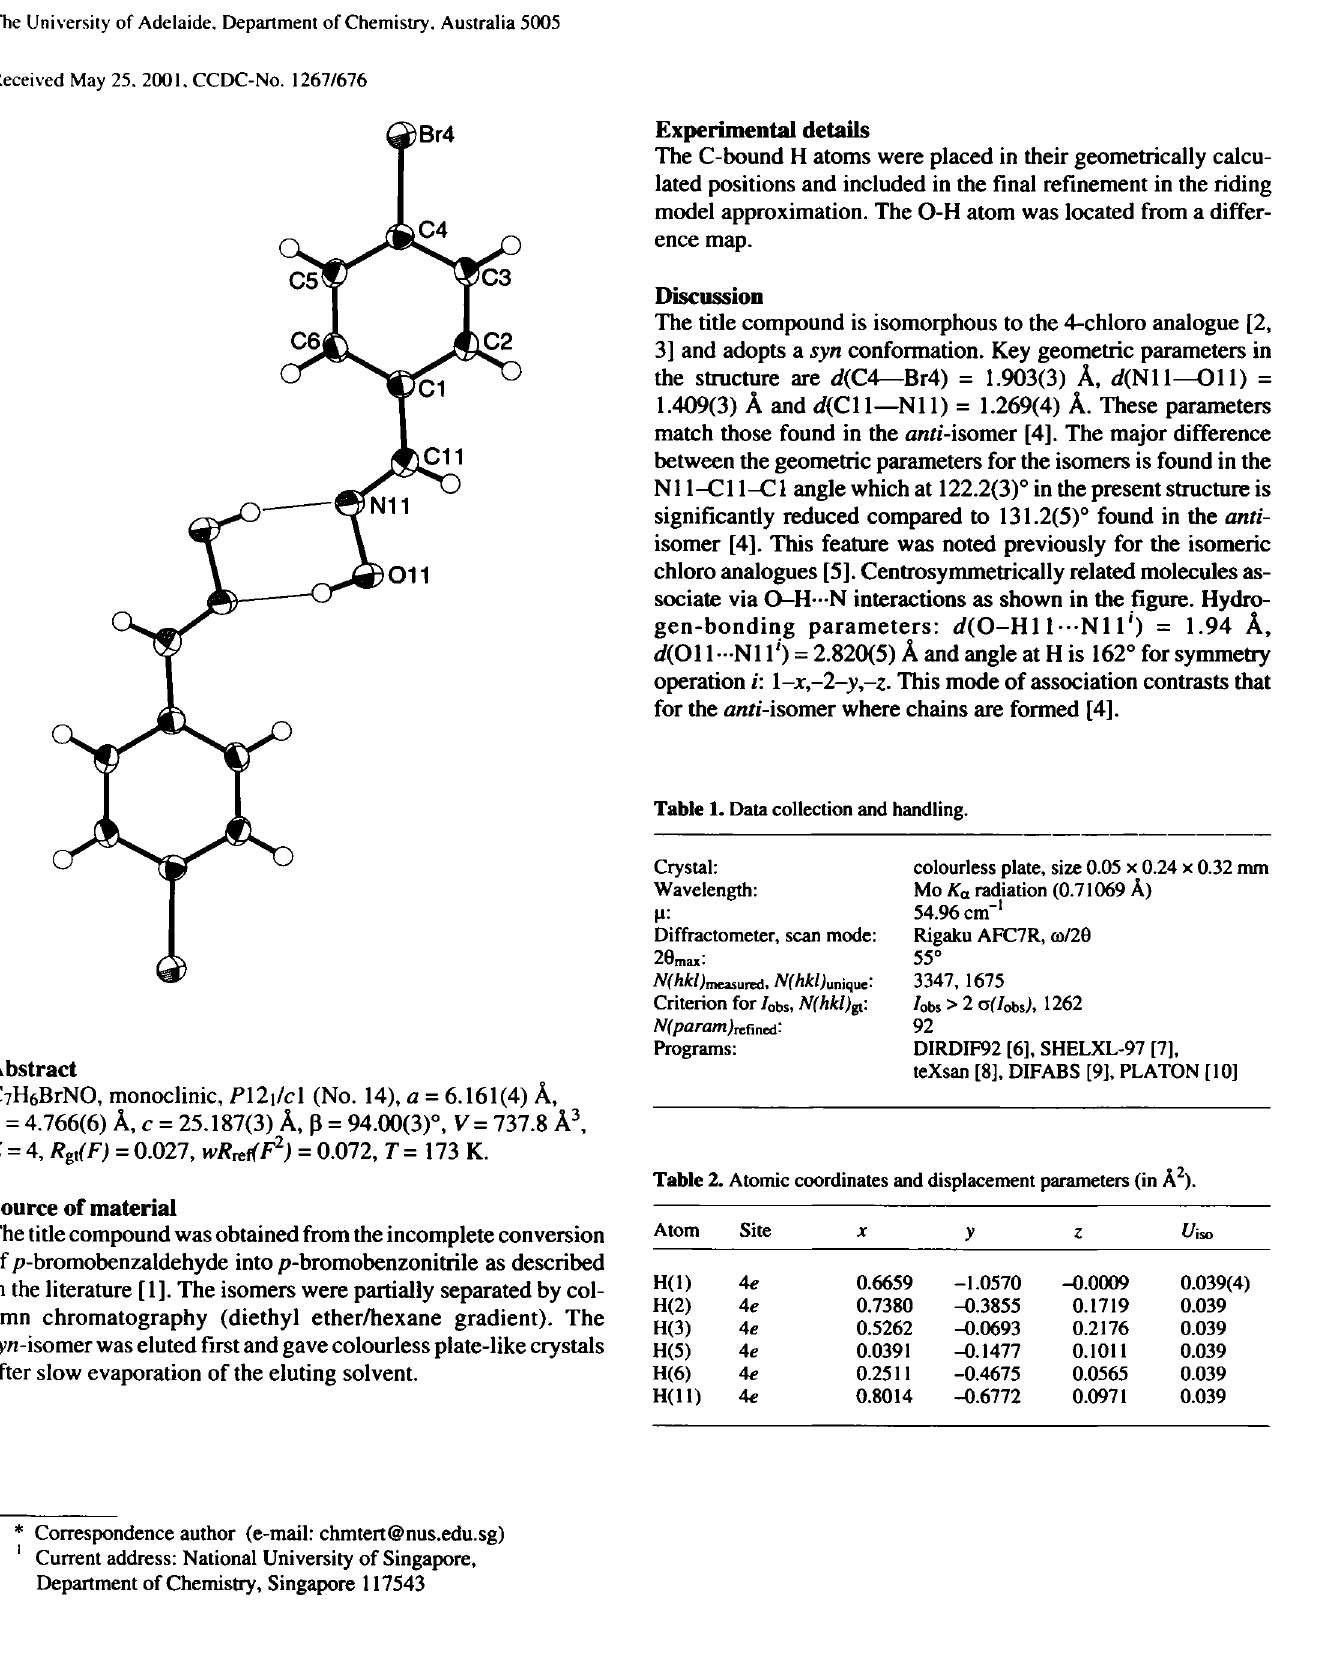
Table 2. Atomic coordinates and displacement parameters (in Ä 2